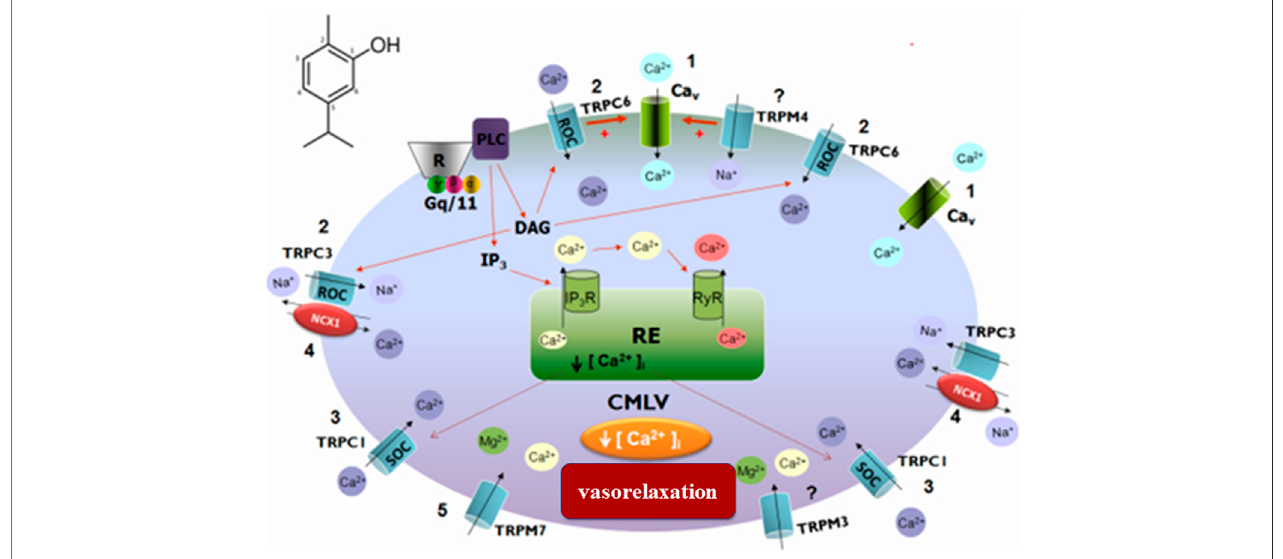
FIGURE 1 | Schematic representation of the probable signaling pathway of the vasorelaxant effect induced by carvacrol. 1) Blockage of calcium in fl ux through the Cav; 2)Blockadeofcalciumin fl uxthroughROCand/or TRPC6;3)Blockadeofcalciumin fl uxthroughSOC and/orTRPC1;4)Action onNCX1byactivationofTRPC3;5) Inhibition of